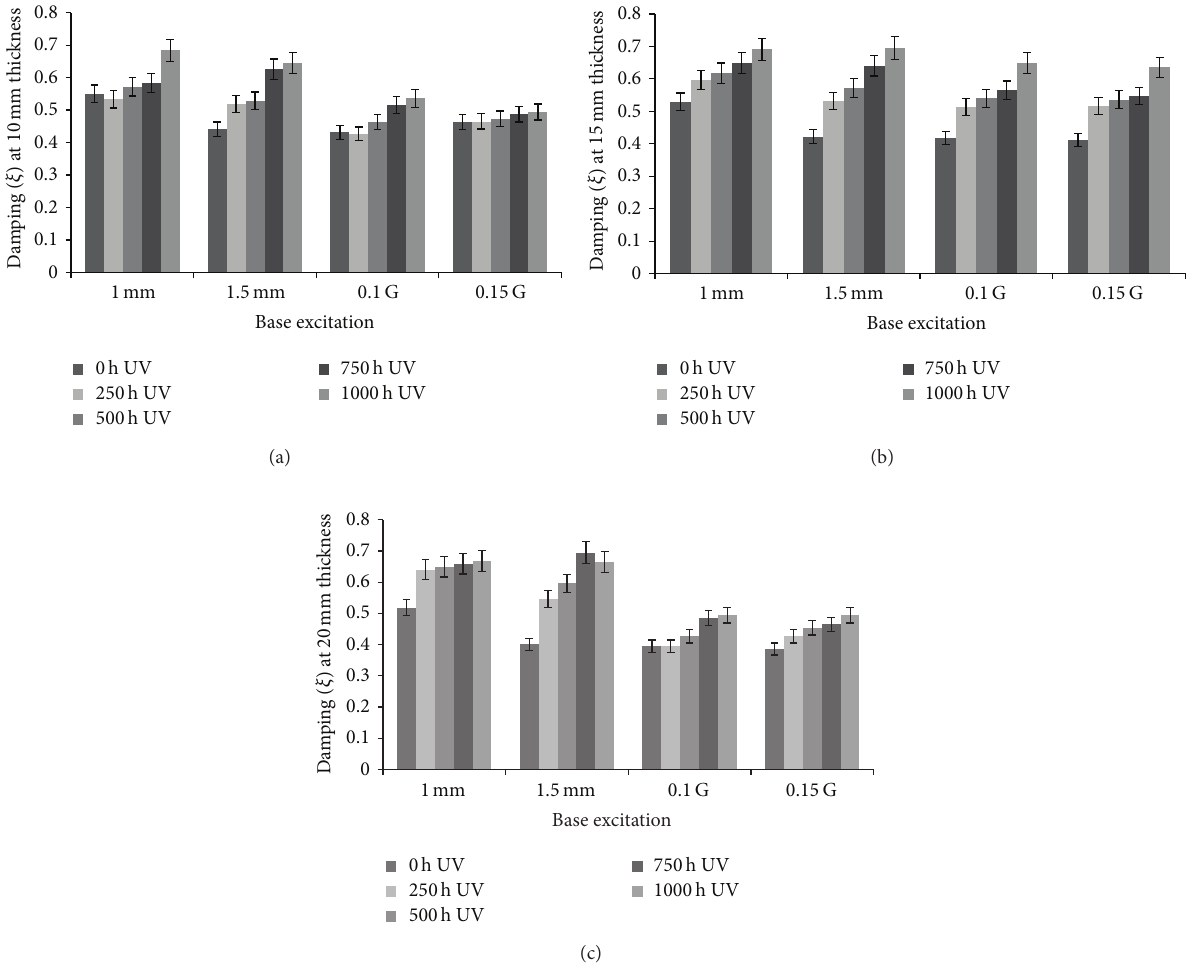
Figure 10: Damping of CBC samples of (a) 10 mm, (b) 15mm, and (c) 20mm thickness at different UV irradiation exposure